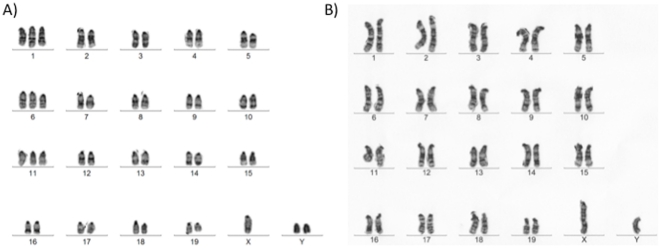
Karyotype analysis of ES cells and live offspring derived from vitrified oocytes.A) Karyotype analysis performed on ViO-ES9 cells revealed a number of abnormalities. The male cell line has a chromosome count of 46. B) Karyotype analysis performed on the mice that were generated from vitrified oocytes revealed normal karyotypes, a representative karyotype for one of the male mice shows a normal 40 XY chromosome count with no abnormalities.